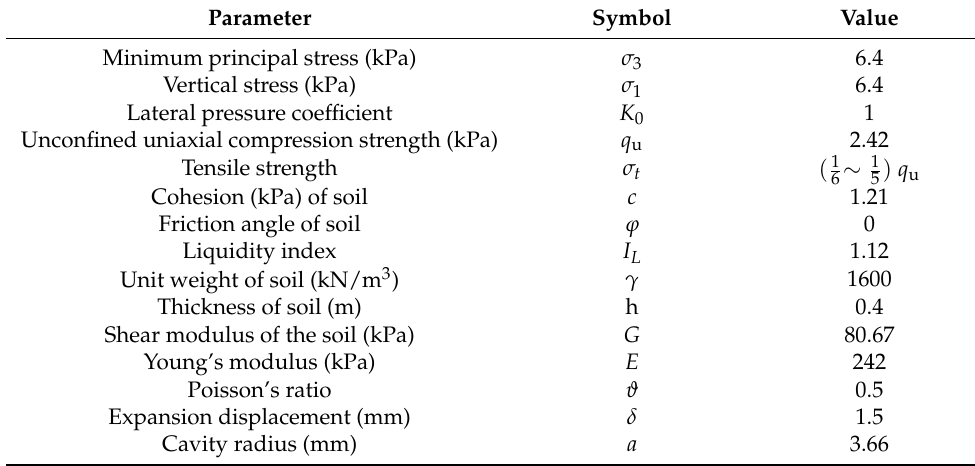
Table 5. Intermediate